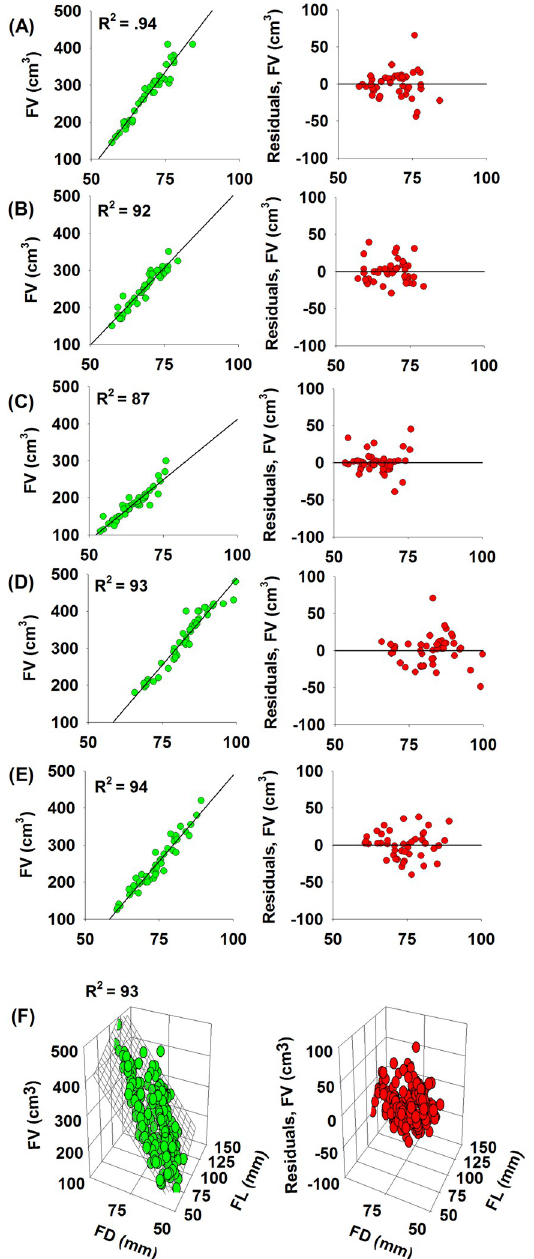
Fig 4. Relationships between FV and FD ( left panel ) and corresponding residual plots ( right ). Figs A-F refers Ettinger (A), Fuerte (B), Hass (C), Nabal (D), Reed (E) and Mixed species